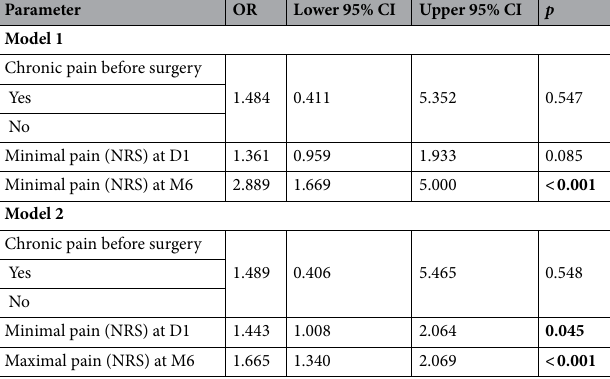
Table 4. Multivariate binary logistic regression analysis of risk factors for CPSP at 12 months (M12). NRS = numeric rating scale. Bold values are statistically significant for p < 0.05.